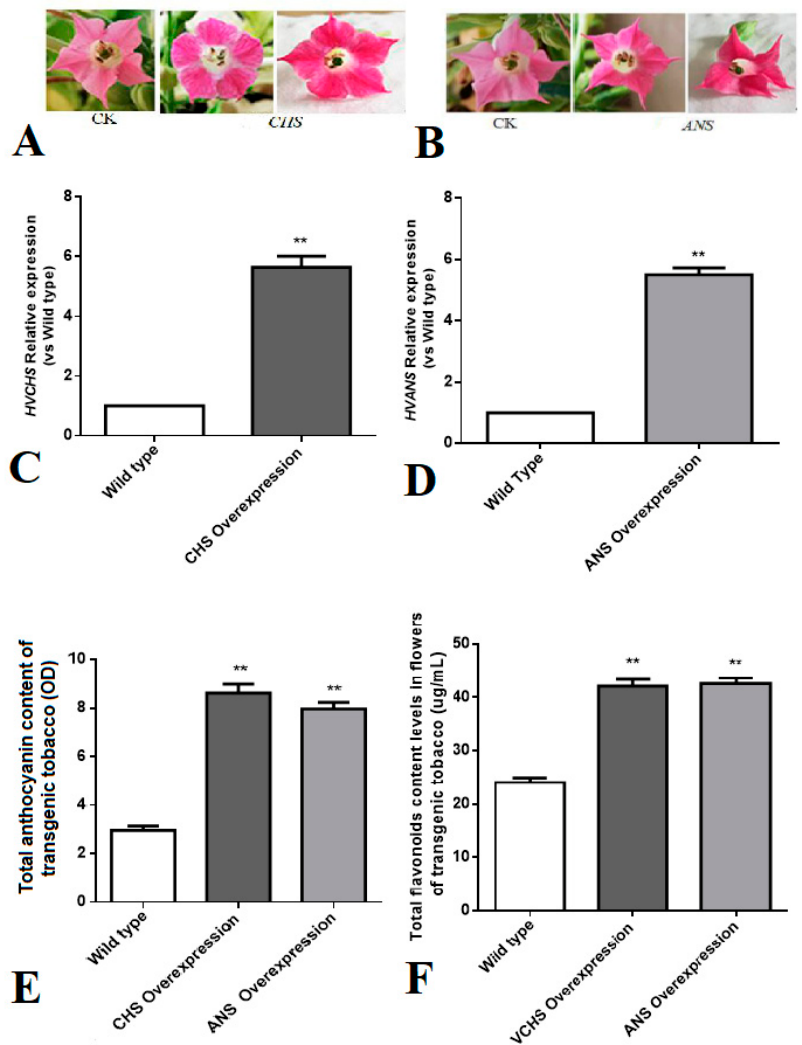
Figure 6. The regulation of flower color by the CHS and anthocyanidin synthase (ANS) genes in tobacco: ( A , B ) the color of the transgenic positive CHS or ANS overexpression of tobacco petals was more deepened than CK (the natural color of tobacco petals); ( C , D ) the relative expression of the CHS and ANS genes was confirmed to be significantly higher in the overexpressing tobacco flowers compared with wild-type tobacco (CHS gene p -value = 0.00194, ANS gene p -value = 0.00324); ( E , F ) the contents of anthocyanins and flavonoids in flowers of transgenic tobacco overexpressing CHS or ANS increased compared with those in the flowers of wild-type tobacco (anthocyanin p -value = 0.00214; flavonoid p -value = 0.00414). The relative mRNA expression of CHS and ANS and the increases in anthocyanin and flavonoid content were statistically di ff erent compared with wild-type tobacco. The data represent the mean ± SD of three independent experiments. ** p < 0.01 vs WT, by One-way ANOVA of GraphPad Prism